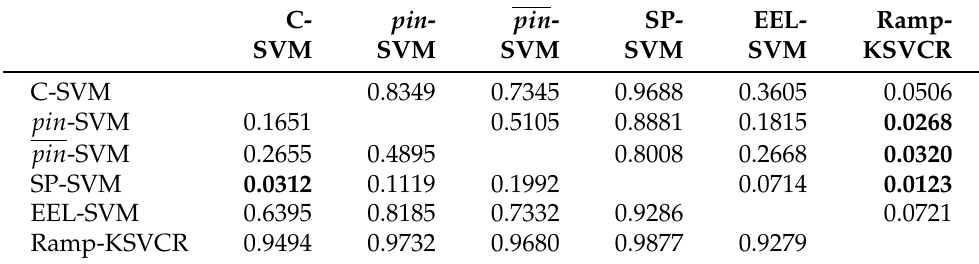
Table 6. p -Values of right-tailed paired sample t -tests. Values lower than 0.05 are bold.